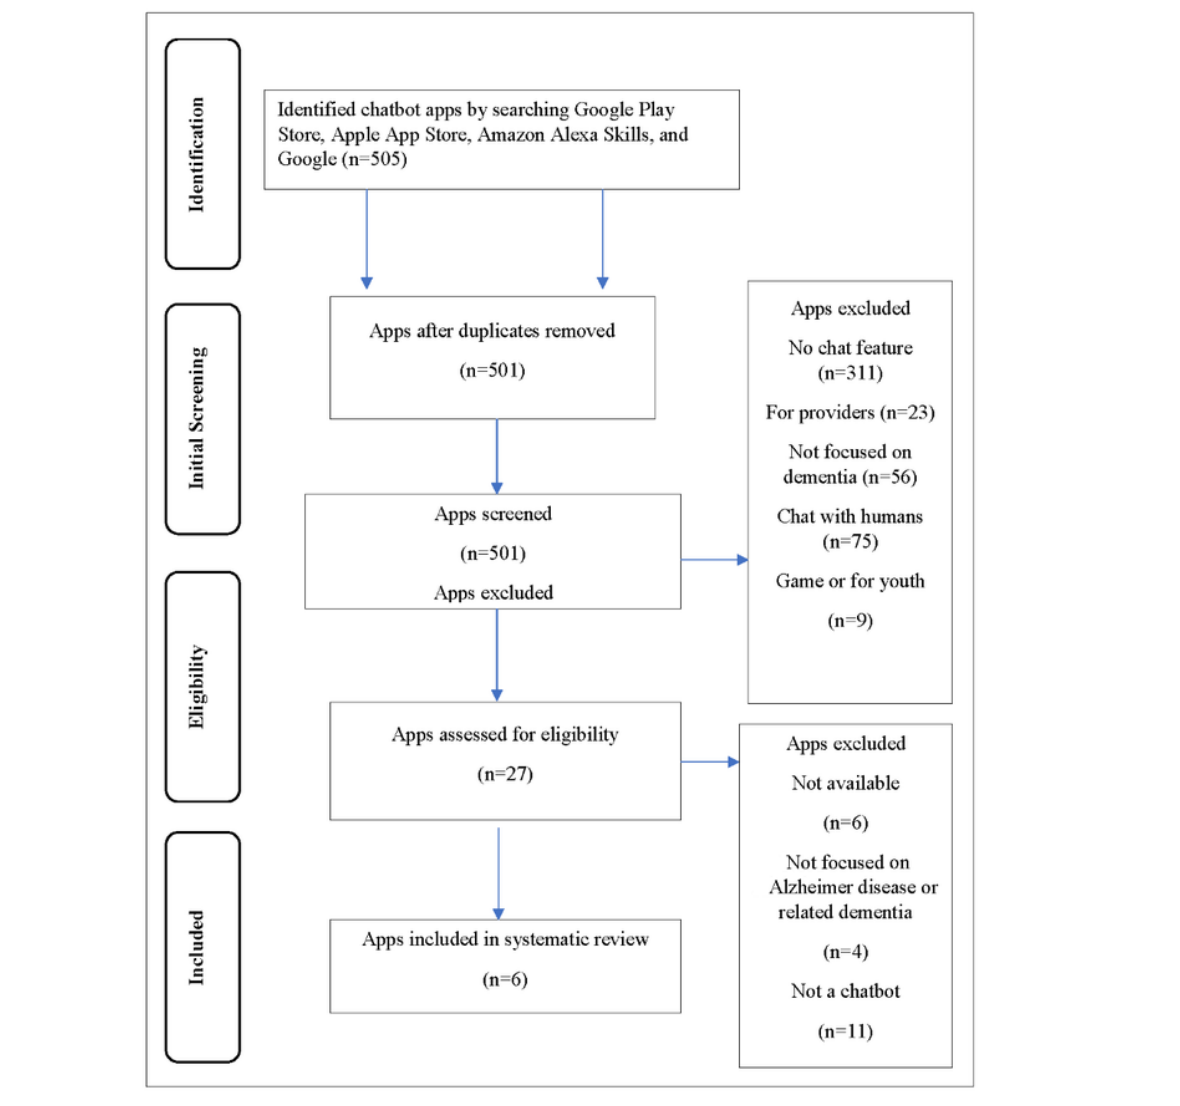
Figure 1. Flowchart of the chatbot apps searched and the screening procedures conducted using the PRISMA (Preferred Reporting Items for Systematic Reviews and Meta-Analyses)